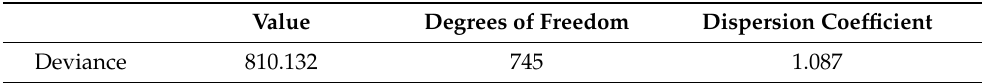
Table 4. Generalized linear model. Goodness of